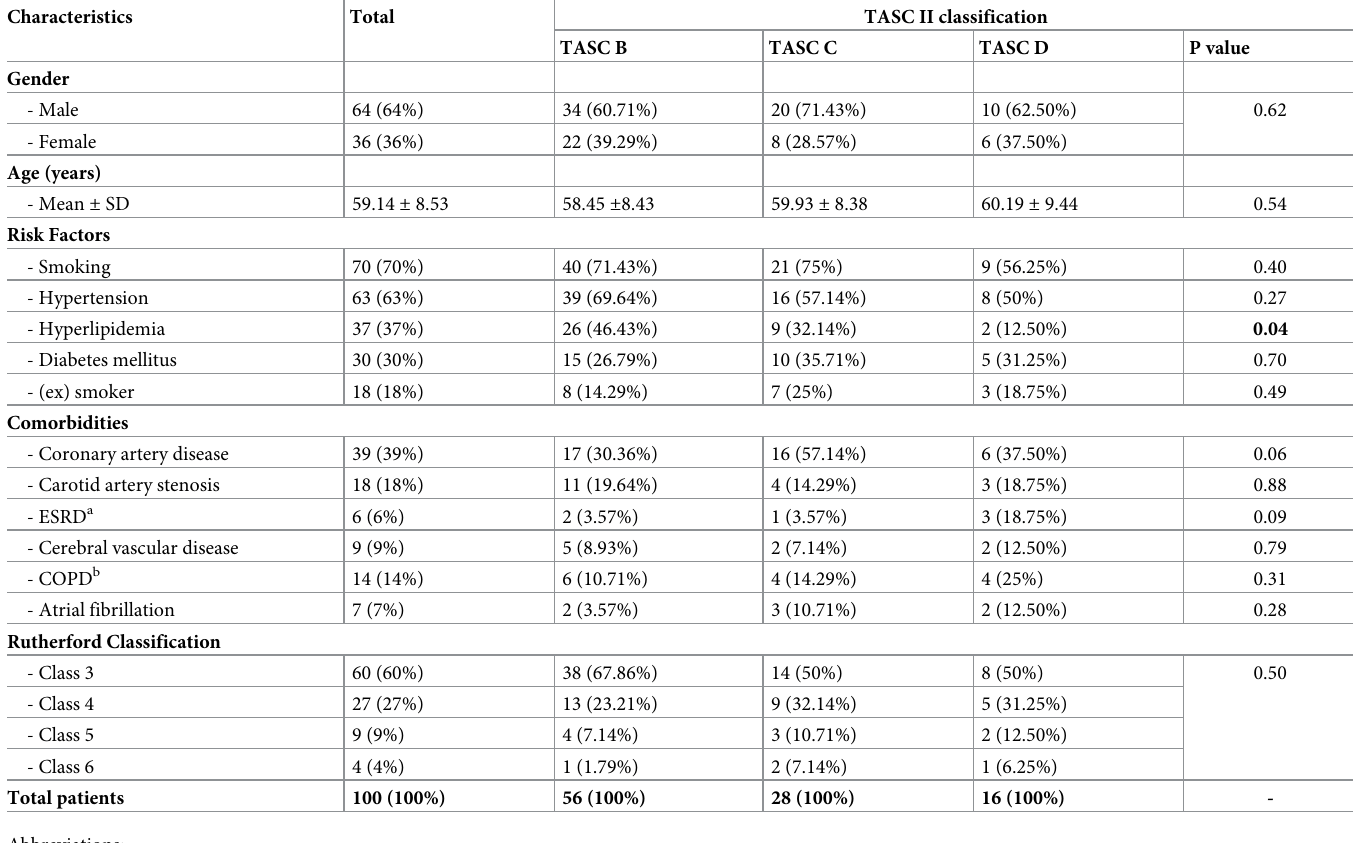
Table 1. Demographic/Clinical characteristics: Whole group and according to TASC II classification.